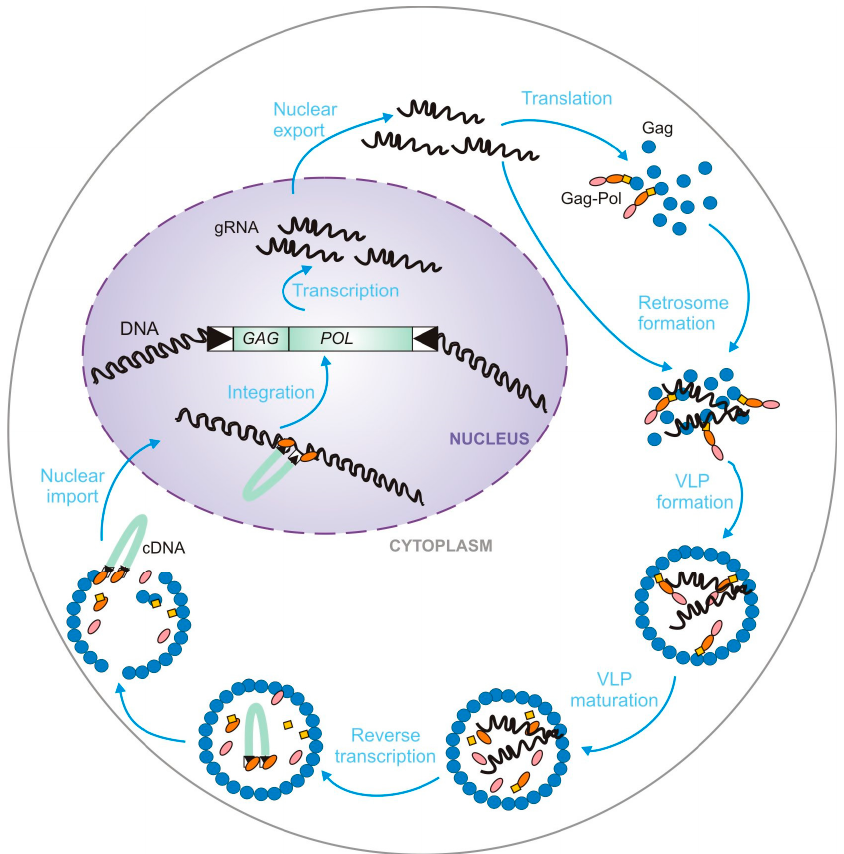
Figure 2. Ty replication cycle with the major steps of retrotransposition outlined. Ty element